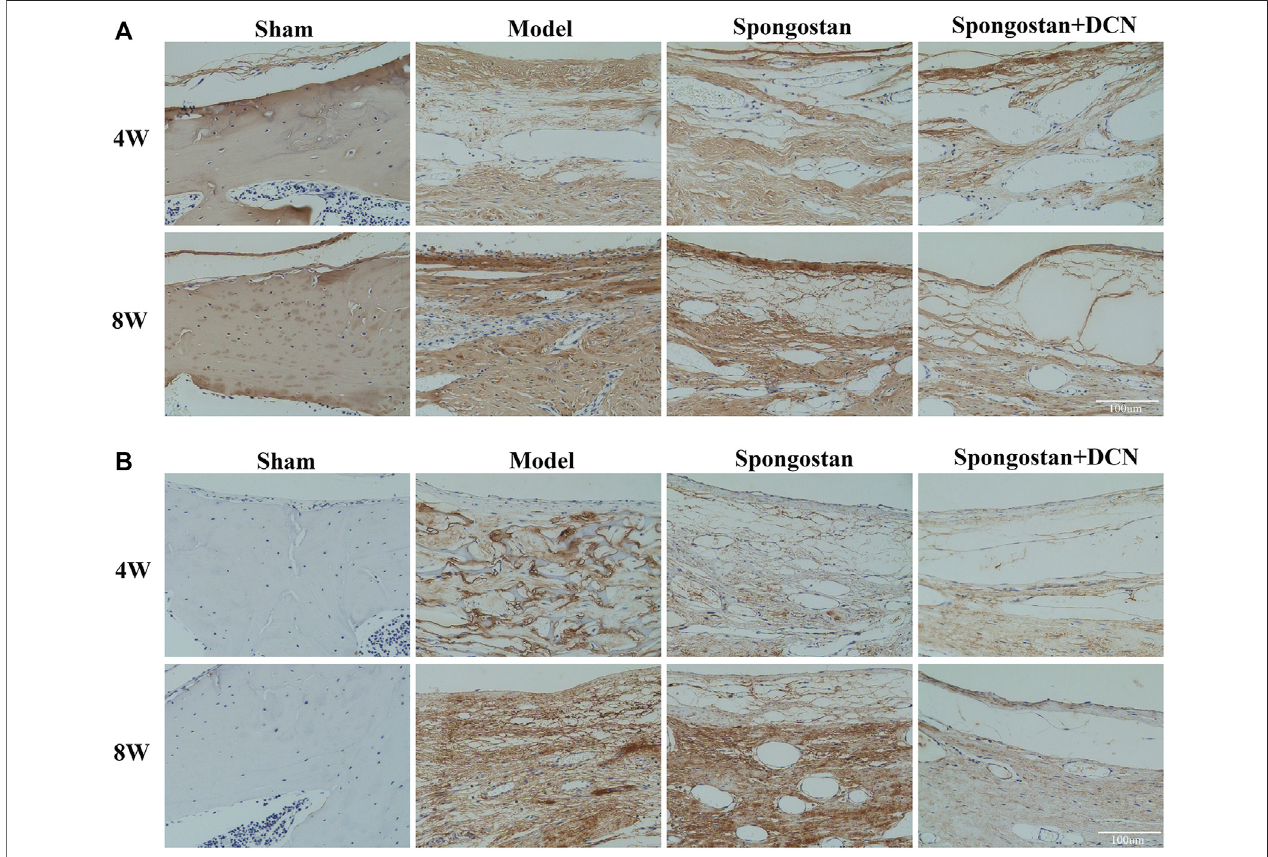
FIGURE 10 | Decorin (DCN) inhibits the synthesis of collagen I and fi bronectin in vivo . Immunohistochemical staining of collagen I (A) and fi bronectin (B) from each group at 4 and 8 weeks, respectively.